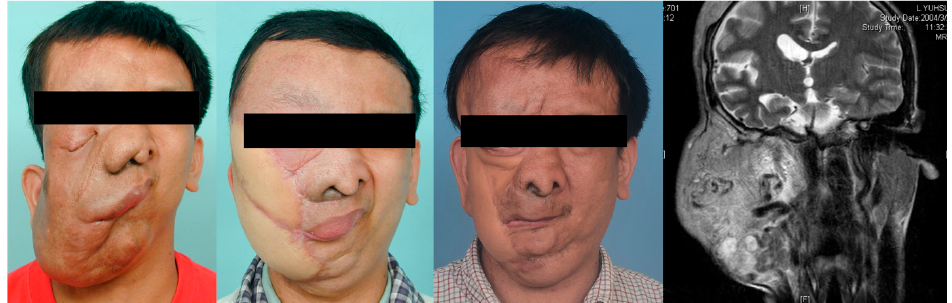
Figure 3. Clinical images of a 30-year-old man with hemifacial plexiform neurofibromatosis exhibiting no ipsilateral facial nerve function and vision. The patient was followed up by the multidisciplinary team for 12 years. Magnetic resonance imaging shows the extent of the plexiform tumor before surgical excision. Two sections of embolization of branches of the right external carotid artery, internal maxillary artery, and superficial temporal artery were completed before radical surgical excision. The distal right external carotid artery was ligated, and the tumor was extensively excised through scalp, preauricular, and submandibular incisions. Microsurgical free flaps (anterior lateral thigh flap and myocutaneous gracilis free flap) were transferred to reconstruct the facial defect. Additional procedures included orbitotomy, tumor resection (nasal and upper lip regions), labial suspension, canthopexies, eyelid reconstruction, and ocular prosthesis placement.